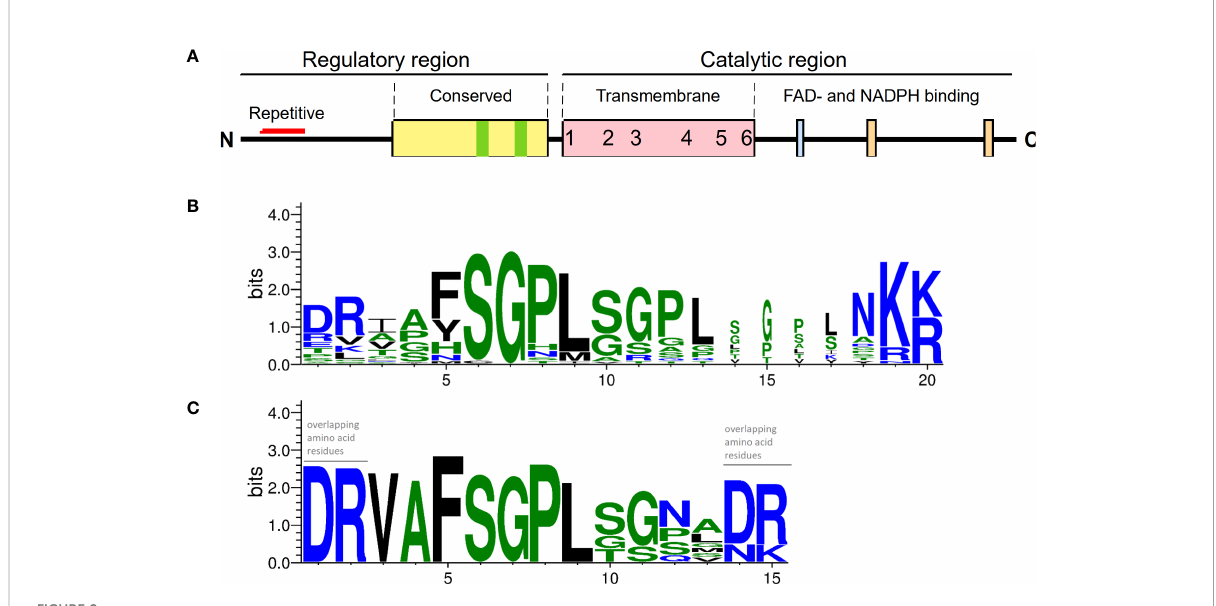
FIGURE 2 A primary structure of PaRBOH1. (A) A schematic model of the PaRBOH1 structure. (B) A sequence logo image of the conservation of the BIK1 target site corresponding to S39 in AtRBOHD in members of the plant RBOH gene family with up to three SGPL-like adjacent motifs (Supplementary Table S3A). (C) A sequence logo image of the BIK1 target site in the N-terminal repetitive motif generated using the four-times repeated motif from PaRBOH1 and the fi ve-times repeated motif from its closest P. taeda homologue (Supplementary Table S3B). Sequence logos were generated by WebLogo (Crooks et al., 2004), hydrophilic charged (blue) and neutral (green) amino acid residues are